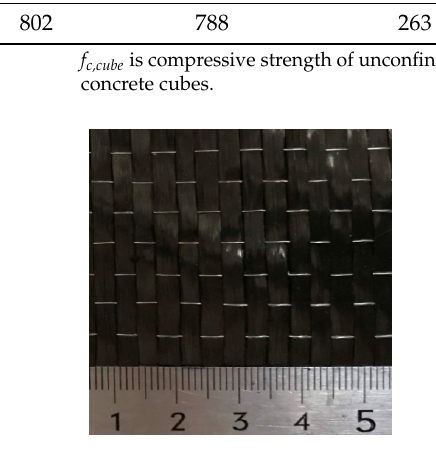
Figure 3. Unidirectional carbon-fiber sheet. Table 2. Mechanical properties of adhesive, CFRP sheets, and steel reinforcement.